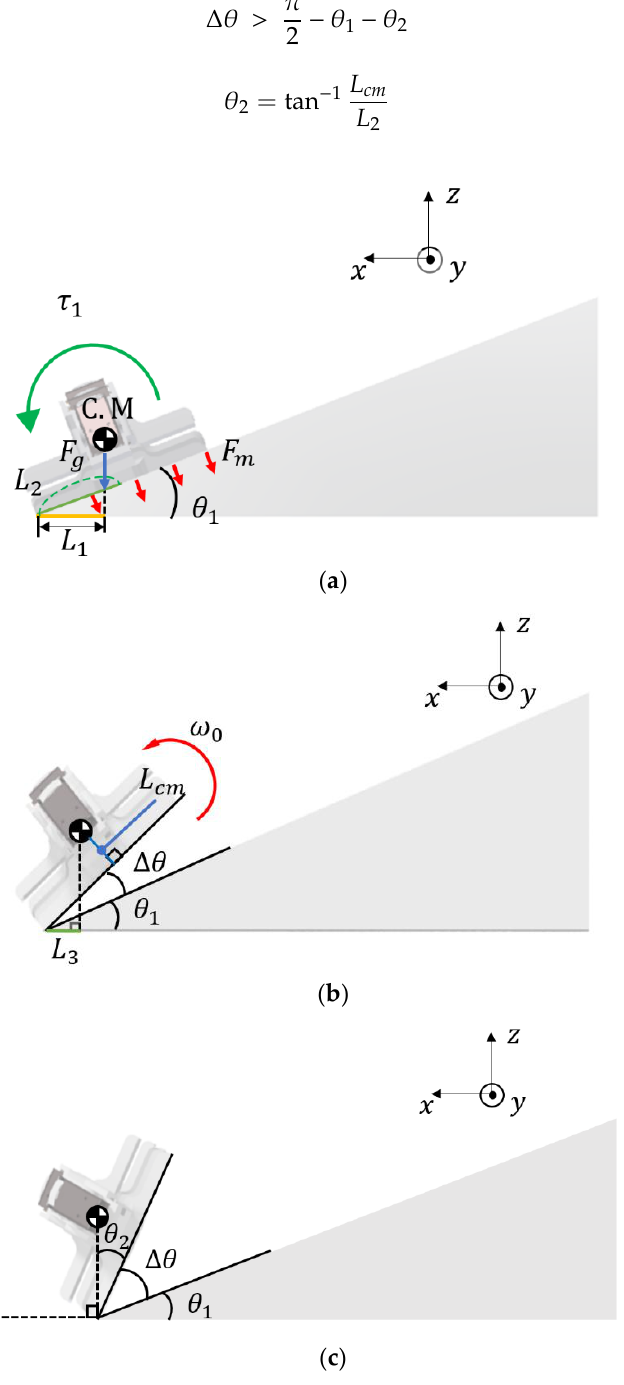
Figure 5. Free body diagram of the dynamic modeling. ( a ) The force which acted on DAM and slope. ( b ) Freebody diagram when the DAM lifted. ( c ) The moment when the center of mass located on the z-axis.